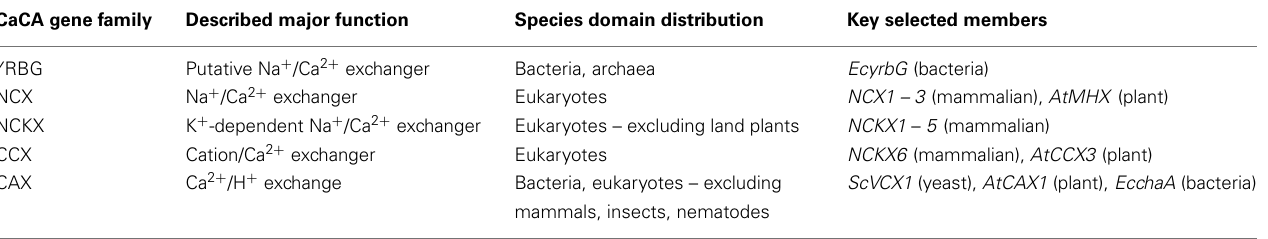
Table 1 | Definition of the five major gene families that make up the CaCA superfamily.